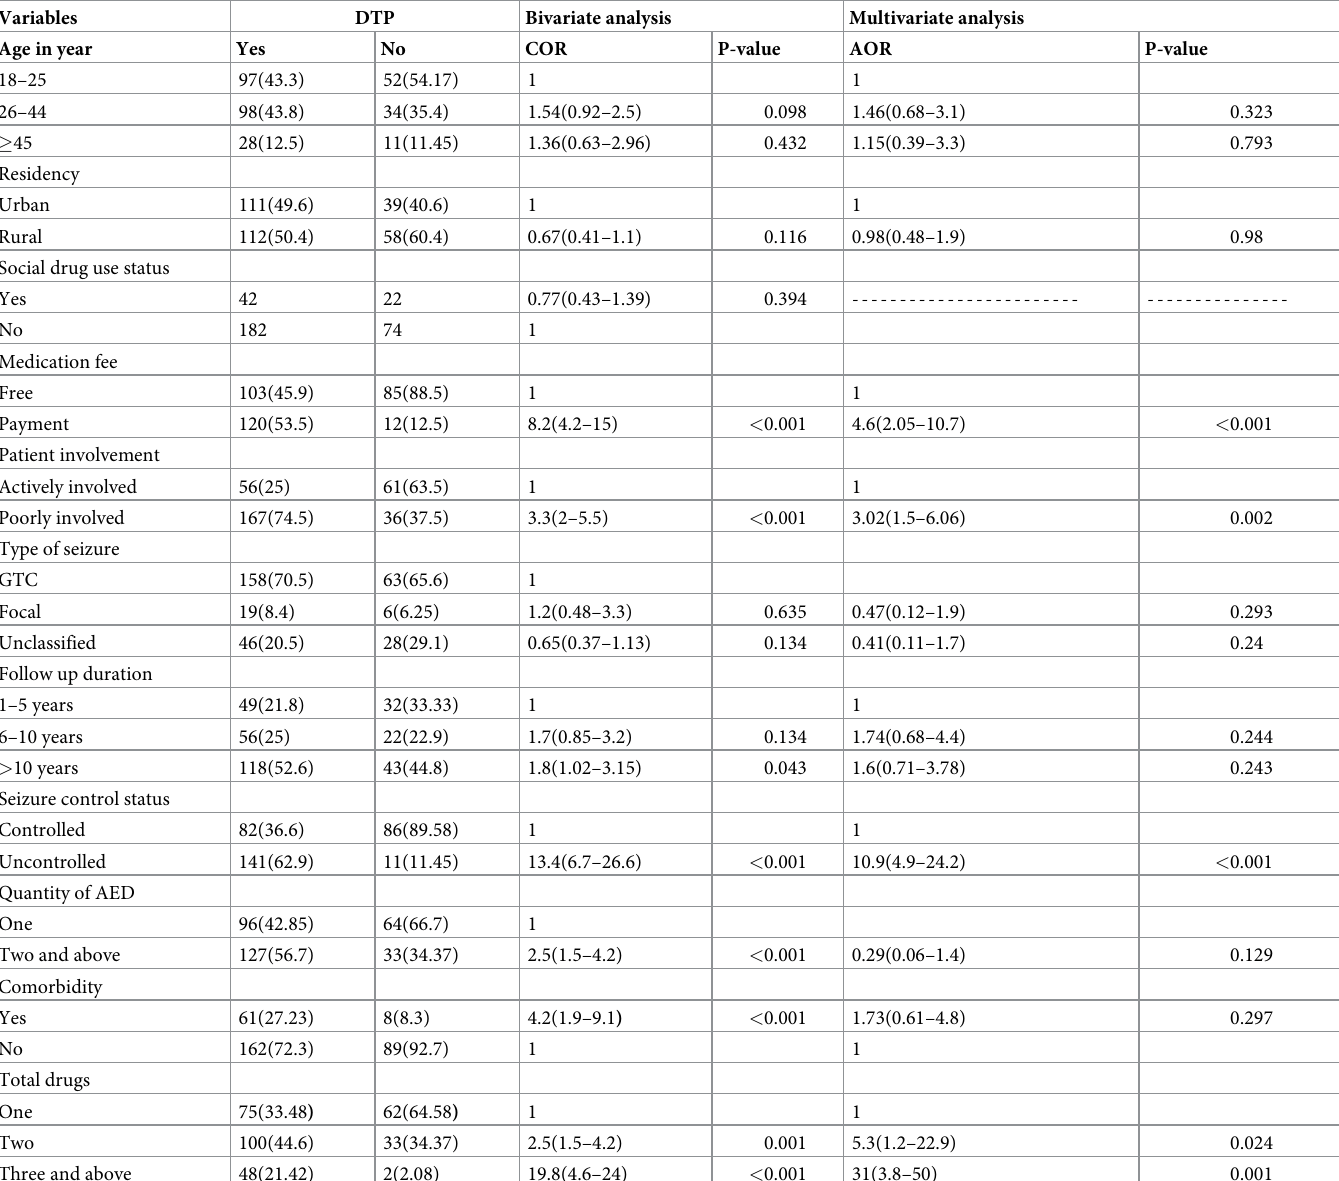
Table 6. Bivariate and multivariate analysis of factors associated with DTPs among epileptic patients attending ambulatory clinic of JMC,